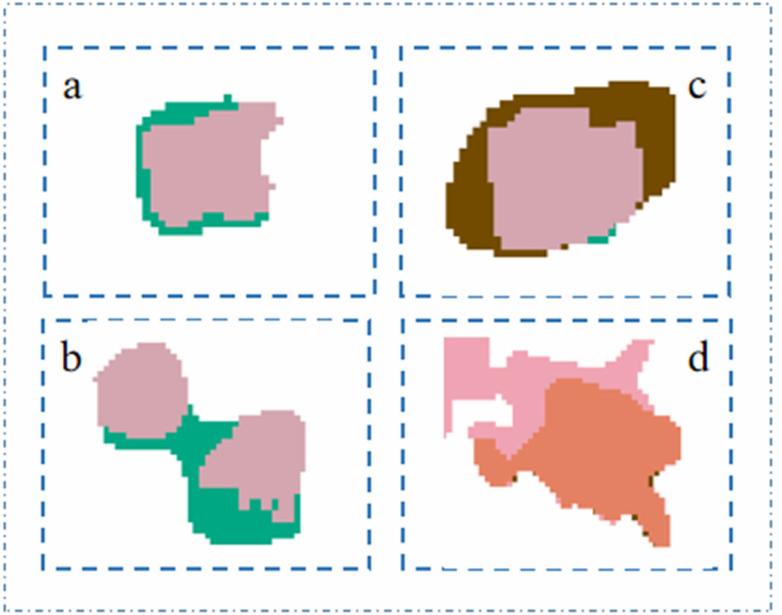
Figure 5. Change pattern of rural settlements. (Note: ( a ): expansion pattern; ( b ): merge pattern; ( c ): retreated pattern; ( d ): urbanization pattern).